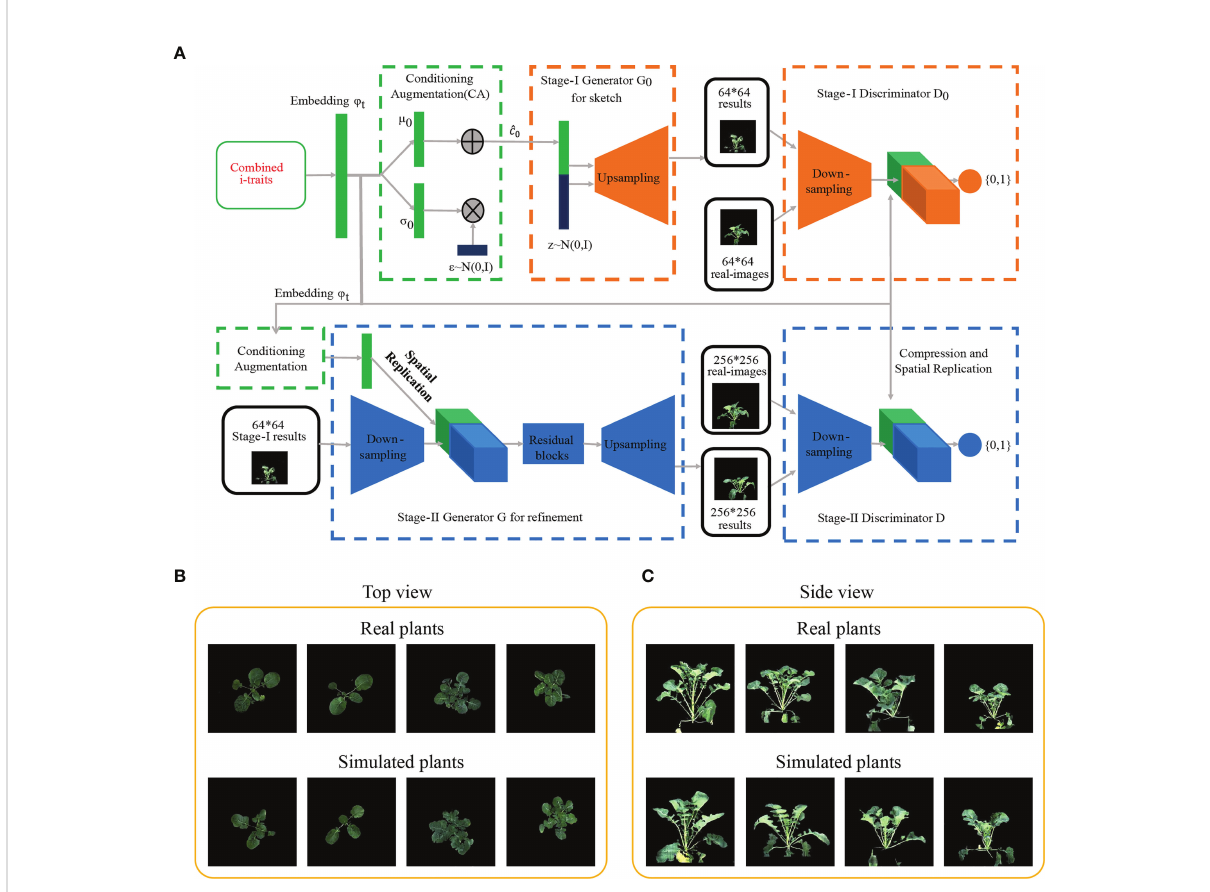
FIGURE 2 Generation of images based on machine learning. (A) Procedure of generating rapeseed images by the StackGANv1 model. (B , C) Comparison of images between real and simulated images generated based on the nine i-traits in top view (B) and ten i-traits in side view (C) from the top 50% i-traits screened by the RF